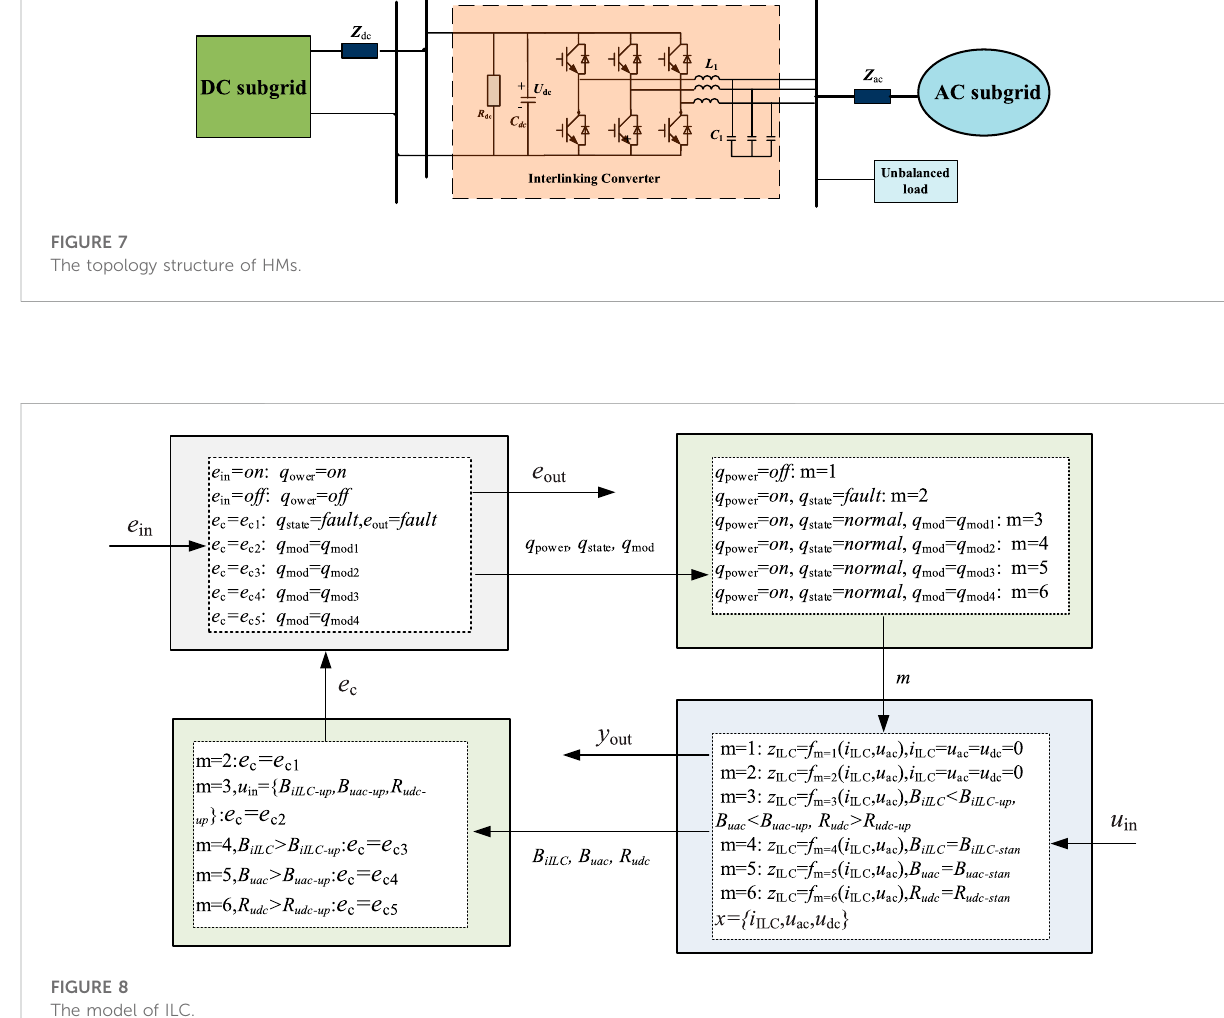
FIGURE 8 The model of